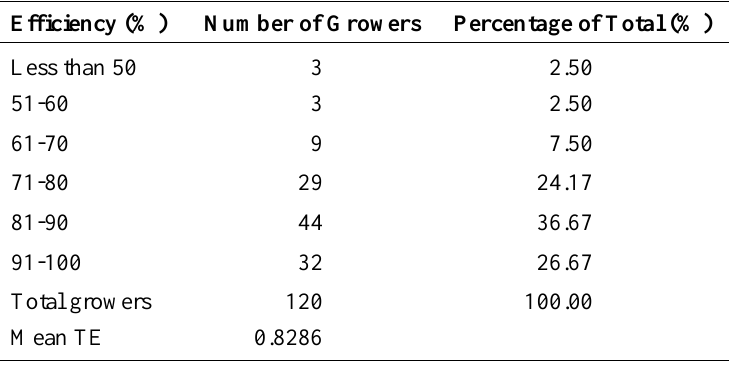
Table 5: Statistical Distribution of Technical